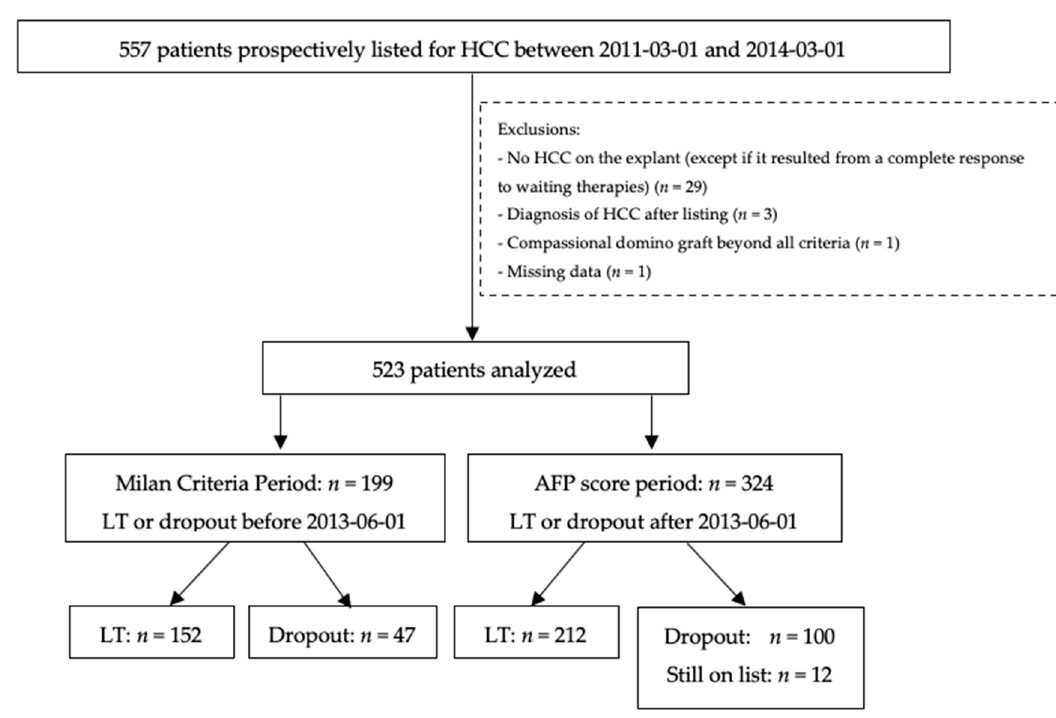
Figure 1. Study flow chart. HCC: Hepatocellular carcinoma; LT: Liver transplantation; AFP: α - fetoprotein